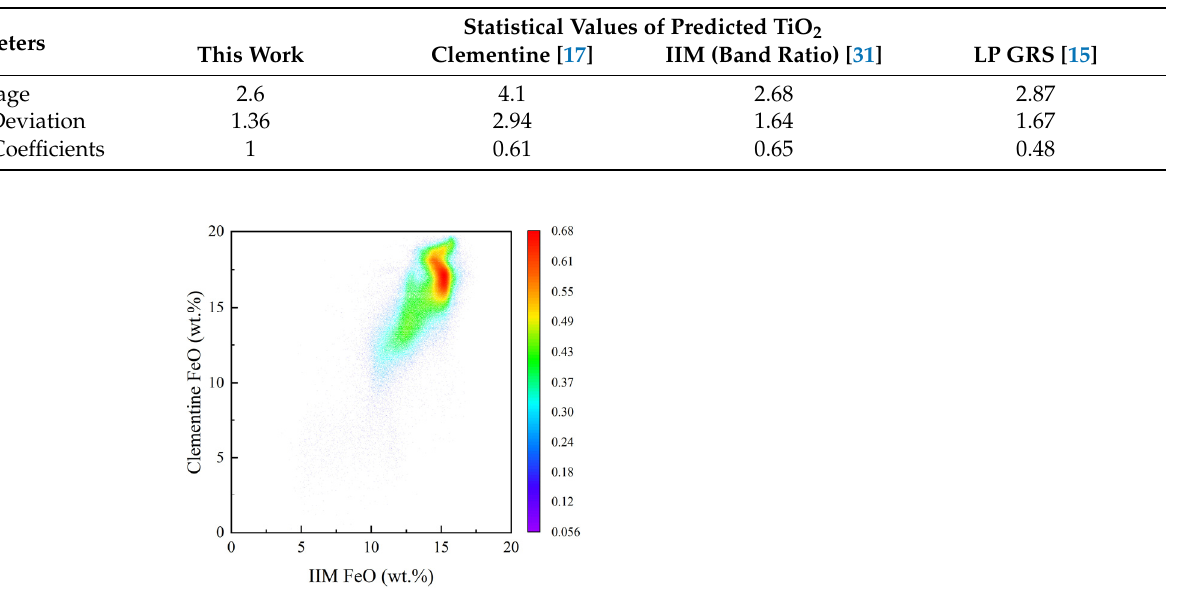
Figure 16. Distribution of TiO 2 based on different data/methods. Table 6. Correlation coefficients based on different data/methods for TiO 2 inversion.